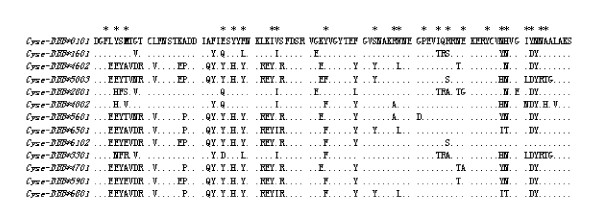
Distribution of MHC class IIB alleles in high-resistance families individuals (white bars) and low-resistance families individuals (black bars) of half-smooth tongue sole. *Asterisks denote P < 0.05. ** denote P < 0.01.